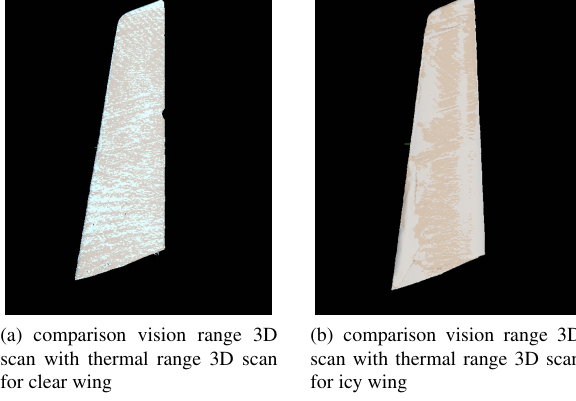
Figure 6. Ice structure images in visible and thermal range At the second stage of the experiments, an ice accretion was formed on the surface of the wing model (Figure 7). This ice model was also scanned by vision and thermal system configura- tions.